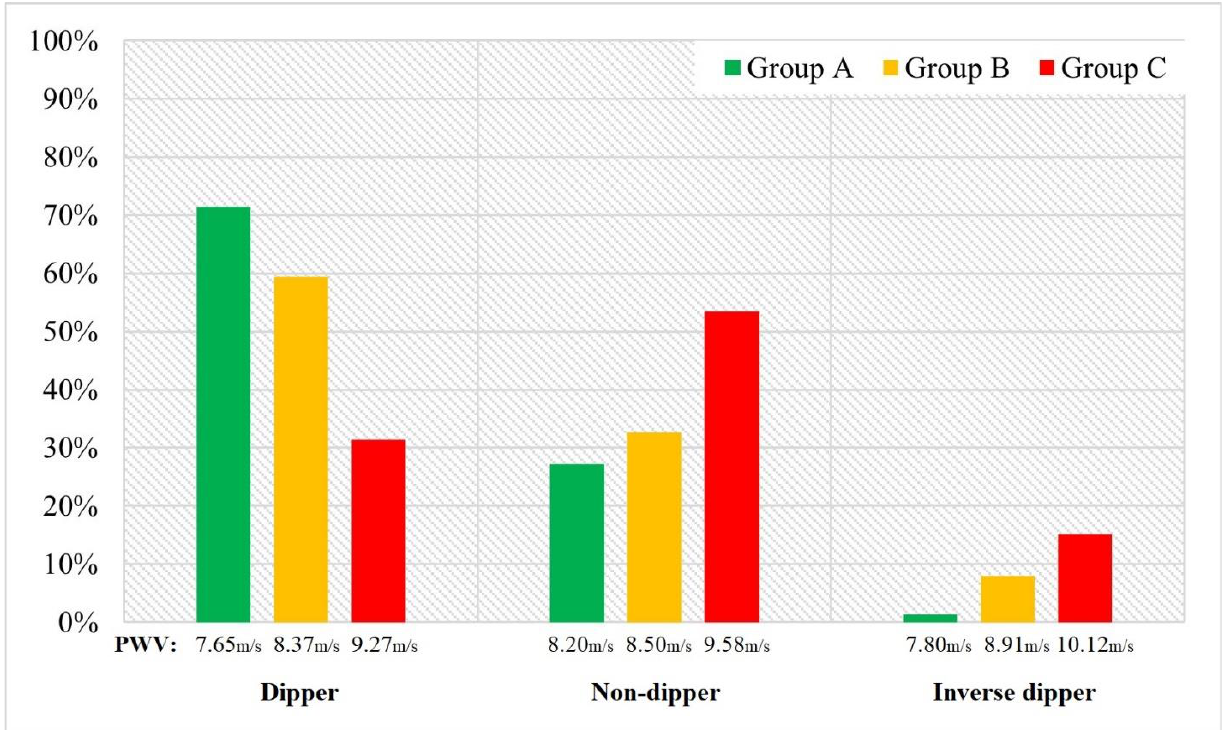
Figure 1. Ratio of subjects with certain dipping profile in examined groups and group pulse wave velocity (PWV) values. Group A = healthy subjects (N = 77); B = subjects with controlled hypertension (N = 138); C = subjects with uncontrolled hypertension (N = 86). PWV values were statistically much higher in subjects with both PreD and a non- dipper profile compared to subjects without PreD and with normal dipper profile in all three age groups (40–50 years: 8.41 vs. 6.69 m/s, p < 0.001; 50–60 years: 8.79 vs. 8.05 m/s, p < 0.01; 60–70 years: 10.24 vs. 9.22 m/s, p < 0.001). Although statistically insignificant, PWV values were slightly higher in non-dippers without PreD than in dippers with PreD (Fig- ure 2), with no significant gender differences in post hoc analysis and the univariate test of significance (F = 0.80, p = 0.370). In PWV analysis among hypertension groups, subjects with PreD and a non-dipper profile had the highest values of all other group subjects without noticeable differences between genders (Table 3). Table 3. Hypertension groups and PWV values depending on dipping status, prediabetes (PreD) and gender. Values represent means ± standard deviation and were analyzed by one-way ANOVA divided by groups. Gender Non-Dipper and PreD (N = 72) Dipper and PreD (N = 64)